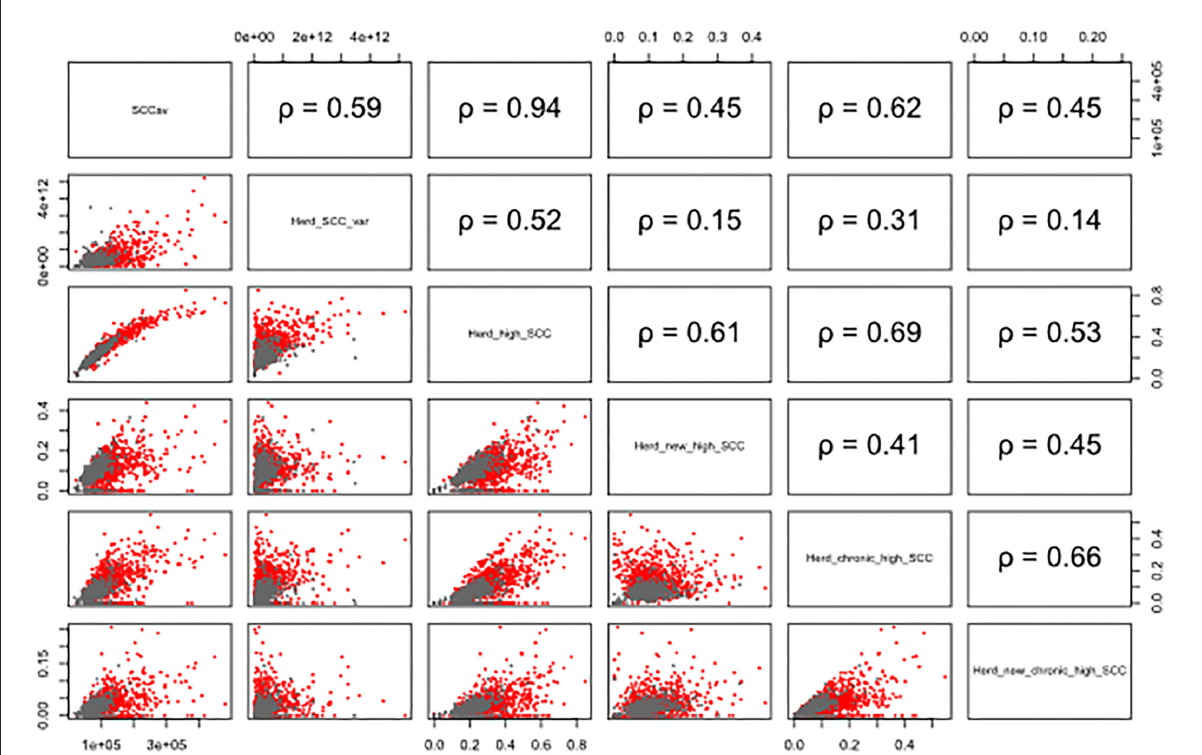
FIGURE1 Scatterplot and the corresponding Pearson’s correlation coefficient ( ρ ) among herd-level subclinical mastitis-related variables of the 131 farms in 11 provinces on a monthly basis. The gray points represent data from company-owned large herds, and red points show the data from family-owned small herds. Herd_SCC, monthly herd average of SCC; Herd_SCC_var, monthly variance of SCC within herd; Herd_high_SCC, monthly proportion of high SCC ( > 200,000 cells/mL); Herd_new_high_SCC, monthly proportion of new high SCC (SCC < 200,000 cells/mL in the previous test, while > 200,000 cells/mL in the current DHI test); Herd_chronic_high_SCC, monthly proportion of chronic high SCC ( > 200,000 cells/mL in ≥ 2 consecutive DHI tests); Herd_new_chronic_high_SCC, monthly proportion of new chronic high SCC (SCC <